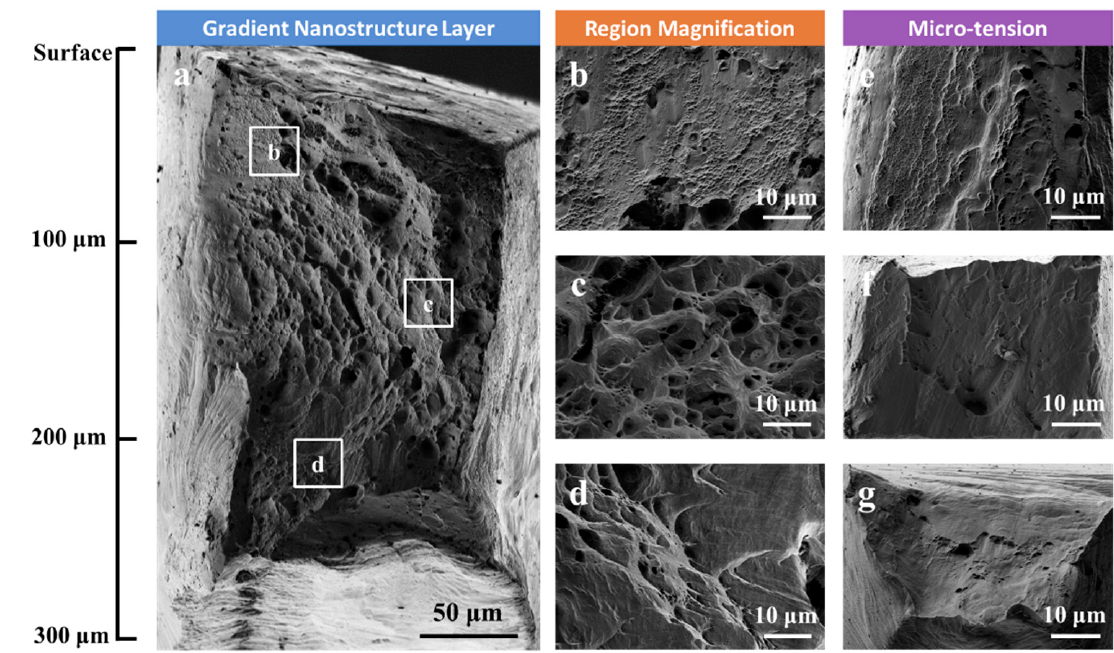
Figure 4. ( a – d ) Lateral morphology of the fractured NG, NT, NT/DS, and GNS specimens, respec- tively. ( e ) Variation of the true fracture strain of aforementioned specimens.